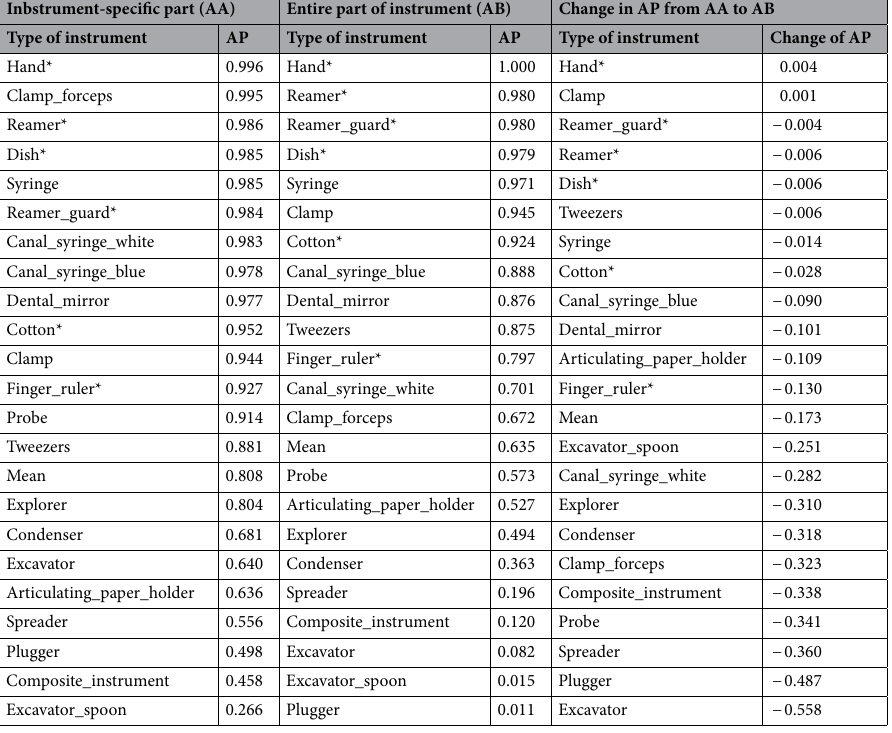
Table 6. AP of Each instrument and changes according to annotation method